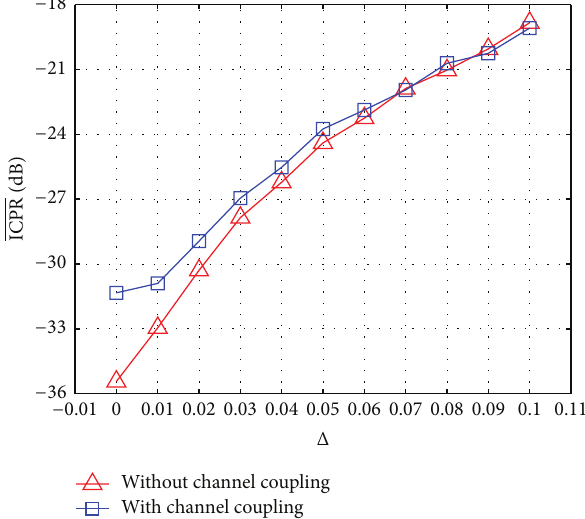
Figure 12: ICPR of a single spherical scatterer and finite beamwidth.